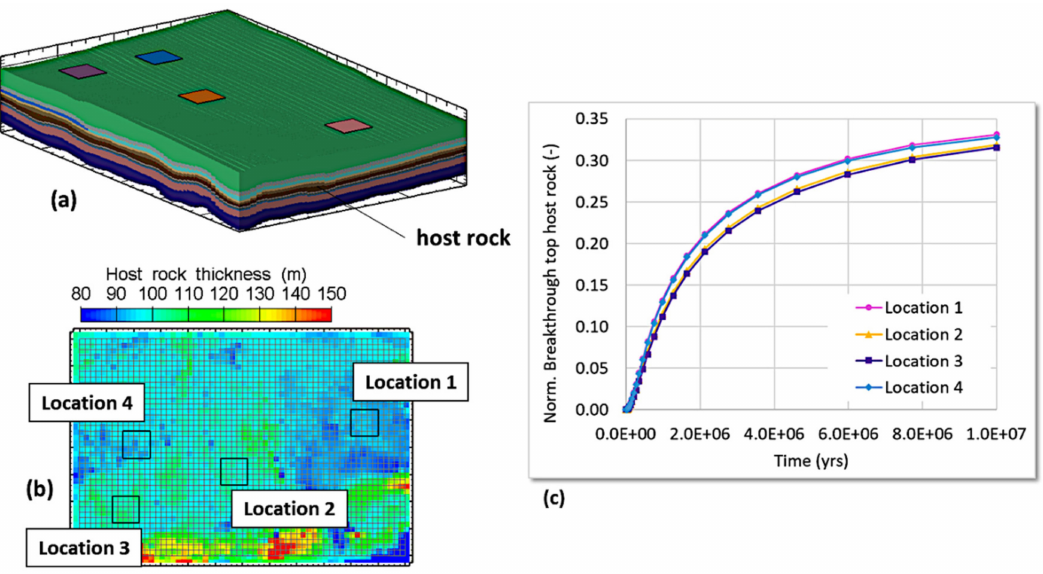
Figure 8. Exemplary 3D model of a siting region used for repository placement: ( a ) hypothetical repository locations projected to top model boundary; ( b ) host rock thickness at corresponding locations; ( c ) normalized tracer breakthrough at the top of the host rock.